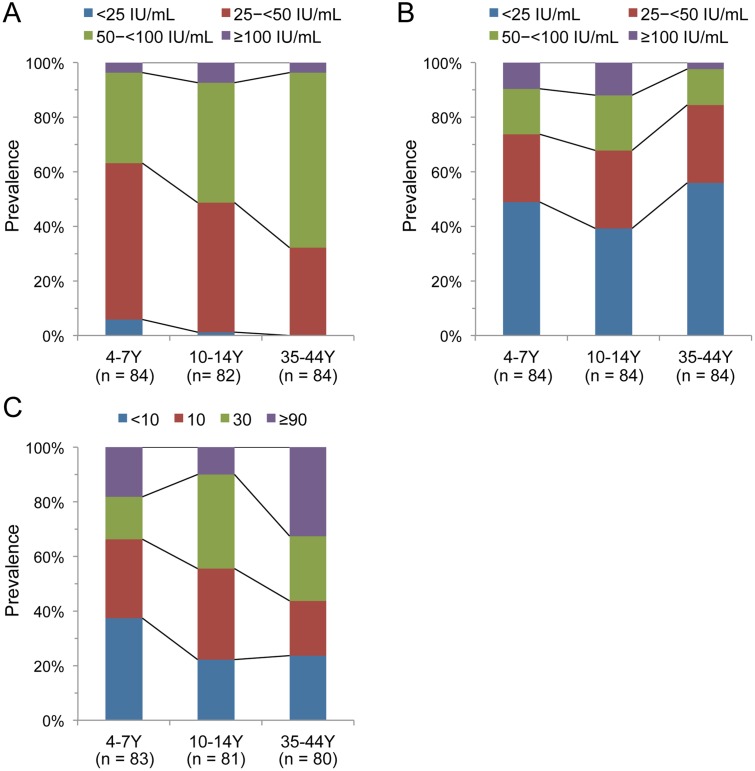
Seroprevalence of pertussis antibodies among young children, older children, and adults during 2013–2014 in Japan.(A) anti-PT IgG, (B) anti-FHA IgG, (C) PT-neutralizing antibodies (the highest reciprocal serum dilution that was needed to neutralize the ability of PT to induce Chinese hamster ovary cell clustering). The age groups were 4–7 years, 10–14 years, and 35–44 years. Numbers in parentheses indicate the number of serum samples that were analyzed. Y, years.